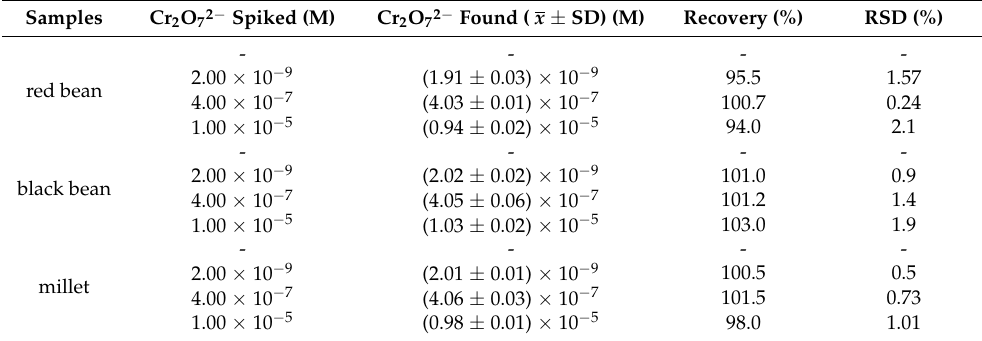
Table 1. Determination of Cr 2 O 72 − in agricultural products samples solution using P(Fmoc-Ala-OH) . Samples